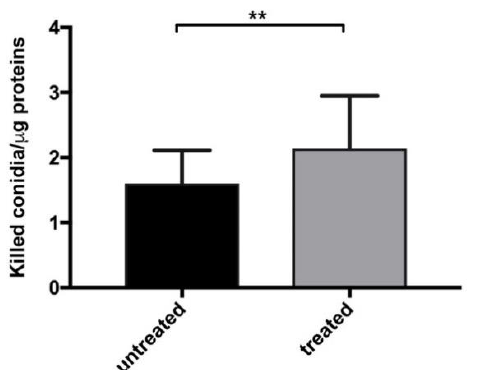
Figure 1. Myriocin (Myr) treatment improved monocyte killing ability. Aspergillus fumigatus conidia were added to patients’ monocytes, untreated or treated with Myr, and cells incubated for 1 h to allow conidia internalization. Non-internalized conidia were then washed, and monocytes were incubated for a further 4 h before undergoing lysis. Live conidia were counted by plating cell lysate on solid medium. To normalize the results, data are expressed as killed conidia / µ g protein. Myr partially rescued cystic fibrosis (CF) monocytes’ killing ability (** p < 0.01 Wilcoxon t -test).